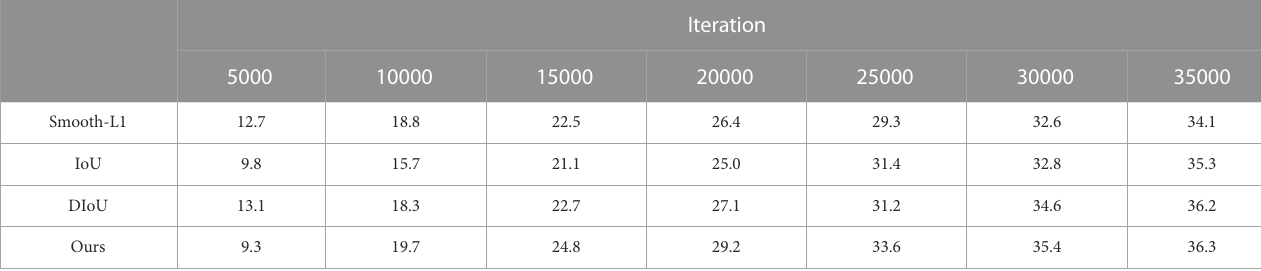
TABLE 6 mAP results after different iterations of training with different loss